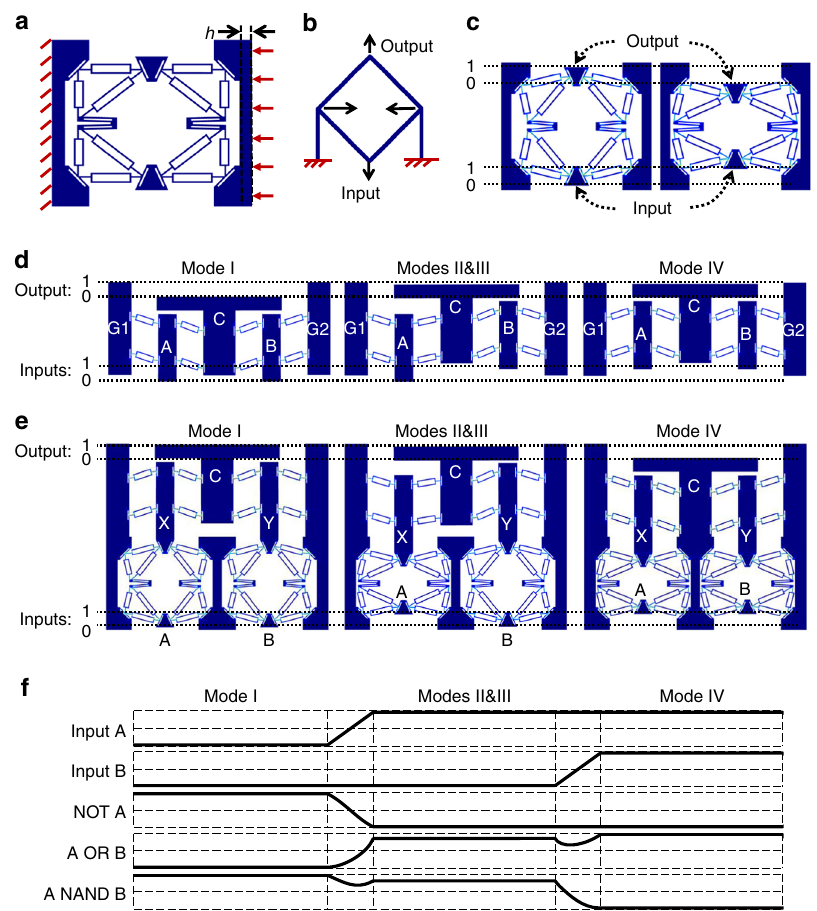
Fig. 2 Design of mechanical logic gates. a Undeformed shape of the NOT gate. b A conceptual design of a mechanical inverter using fl exible beams. c Geometry con fi gurations of the NOT gate at the two stable states representing the negation of logic 0 and logic 1, respectively. d Geometry con fi gurations of the OR gate at Mode I (0 OR 0), Modes II & III (0 OR 1 and 1 OR 0), and Mode IV (1 OR 1). e Geometry con fi gurations of the NAND gate at Mode I, Modes II & III, and Mode IV. f Quasi-static timing diagram of the outputs of NOT, OR, and NAND when the inputs (A, B) transition from (0, 0) to (1, 0) to (1,